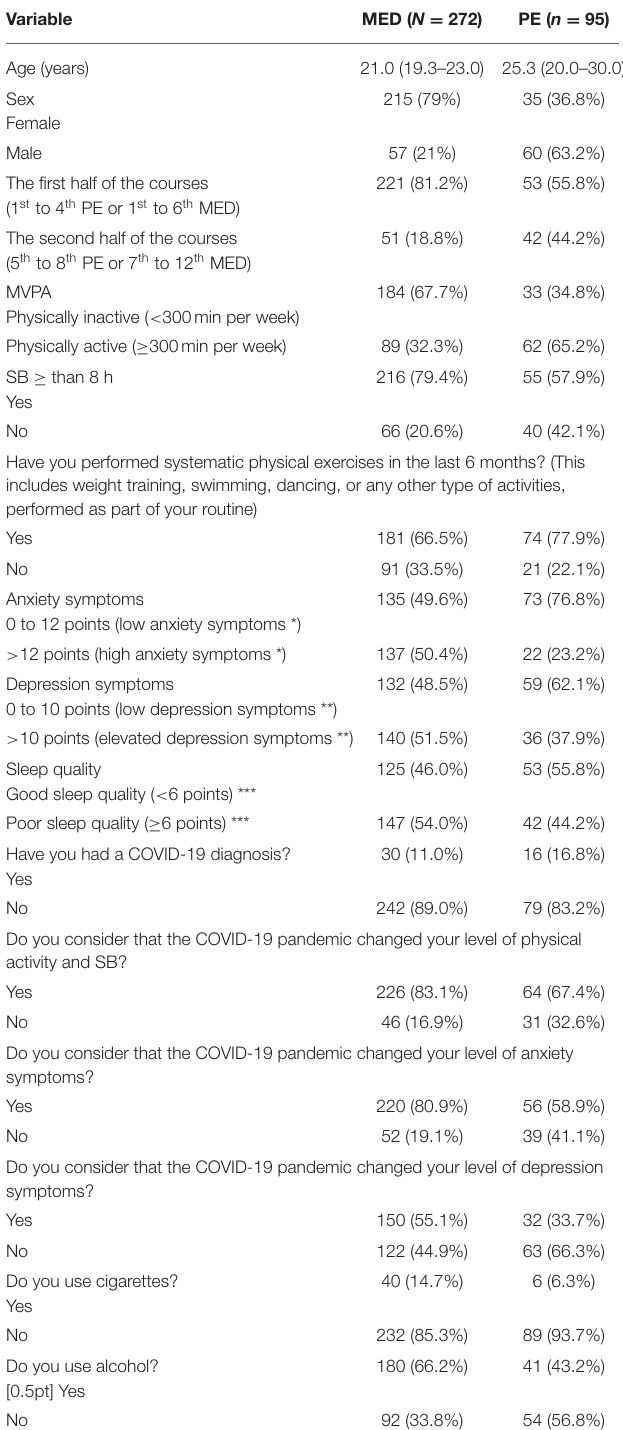
TABLE 1 | Sample characteristics of medical (MED) and physical education (PE) students.